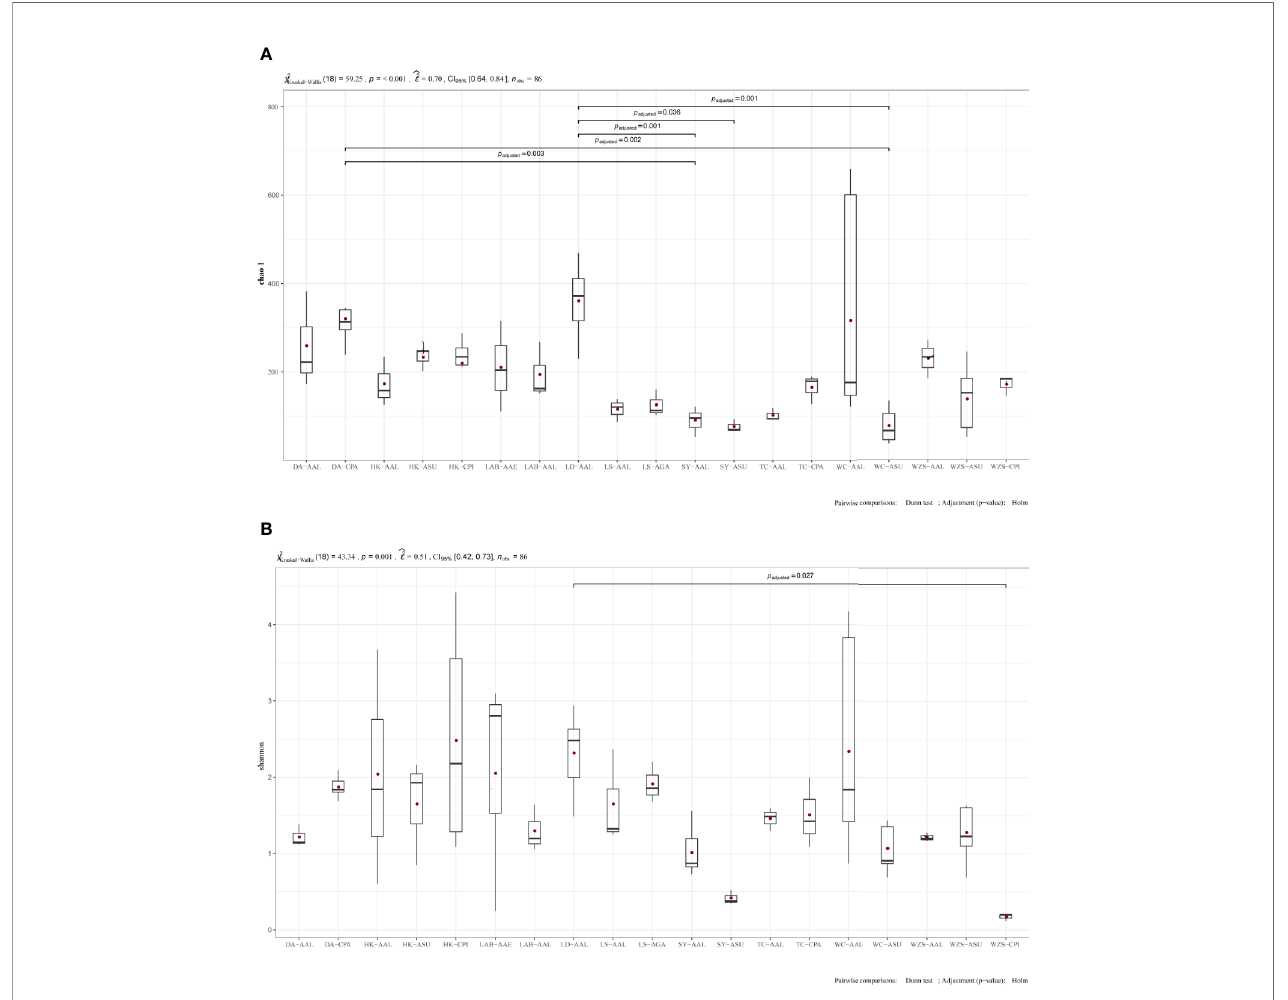
FIGURE 5 | Boxplot representation of observed species. Boxplots show distribution of bacteria between mosquito samples categorized under different locations and mosquito species. Boxplot representation of chao1 (A) and Shannon diversity (B) . Signi fi cant differences between the groups were investigated by Pairwise comparisons of means: Dunn test; Adjustment (p − value): Holm. Species richness is represented by the number of bands. Box plots show median value and minimum and maximum values. Black lines indicate medians and the value is shown in the fi gure. Values from all statistical tests are available in additional Table 2